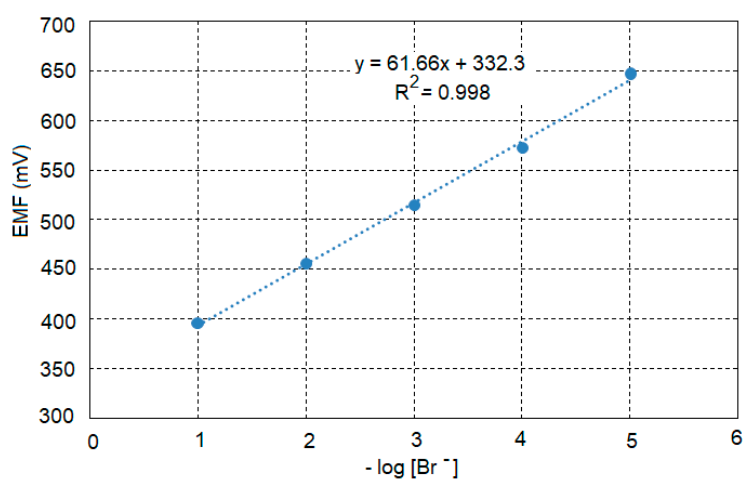
Figure 6. The potentiometric response of sensor B toward bromide after 4 weeks.